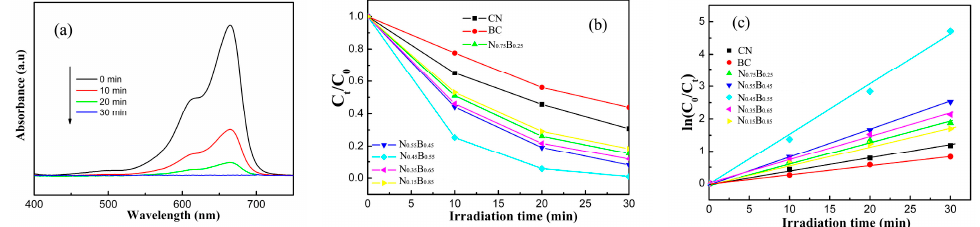
Figure 8. ( a ) Time-dependent absorption spectra of MB aqueous solution degraded by N 0.45 B 0.55